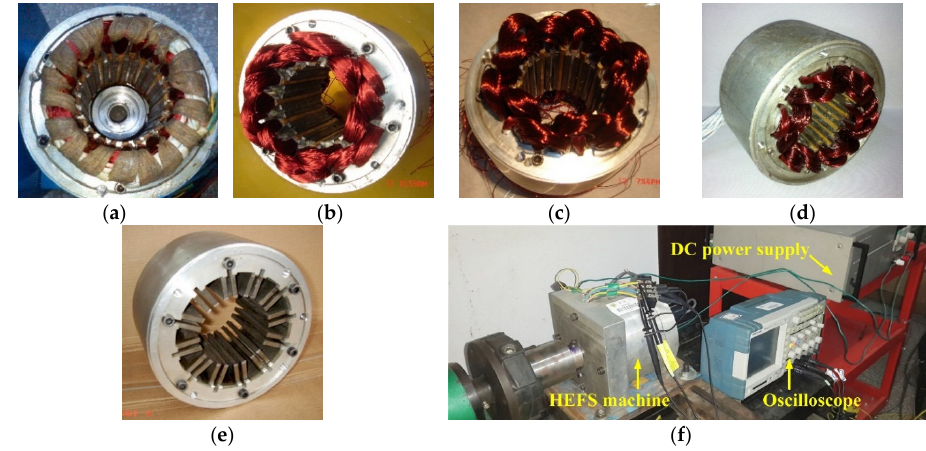
Figure 19. HEFS machine prototypes and experimental platform. ( a ) Stator of PM ‐ top machine; ( b ) Stator of PM ‐ bottom machine; ( c ) Stator of PM ‐ middle ‐ 1 machine; ( d ) Stator of PM ‐ middle ‐ 2 machine; ( e ) Stator iron and housing; ( f ) Experimental platform and instruments.